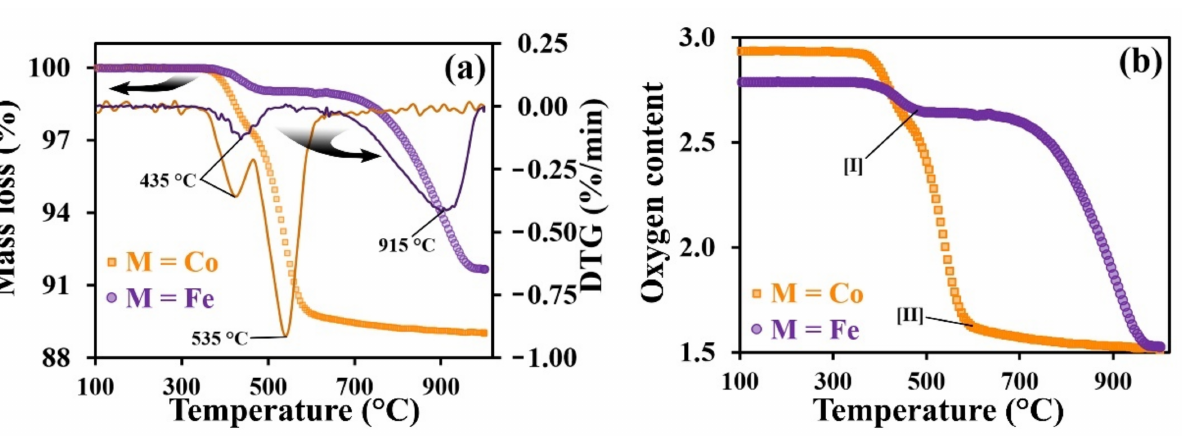
Figure 3. Thermogravimetric data of the PrNi 0.4 Fe 0.6 O 3– δ and PrNi 0.4 Co 0.6 O 3– δ powders: TGA and DTG data ( a ) and oxygen content in oxides during reduction in H 2 ( b